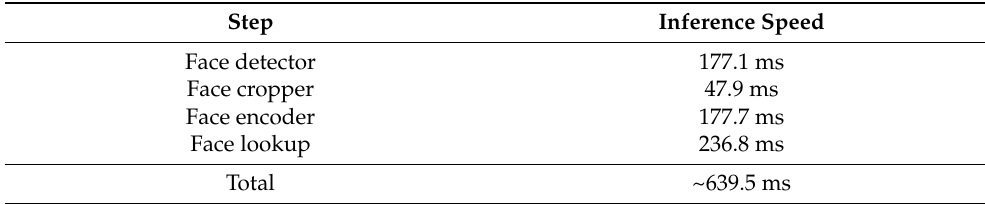
Table 4. Matching speed of the pipeline running on Jetson Nano.